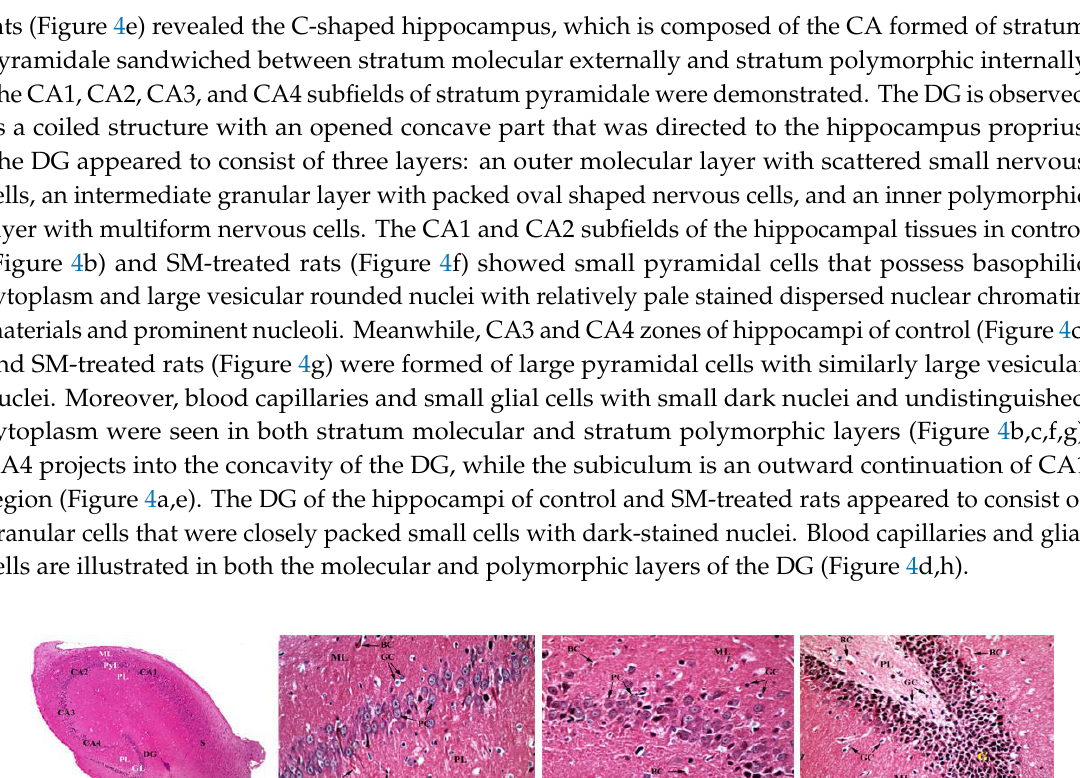
Figure 5. Photomicrographs of the hippocampal tissues of AlCl 3 -treated rats stained with Hx&E showing ( a ) disruption of normal laminar organization, where the hippocampus appeared flattened, formed of CA1, CA2, CA3, and CA4 subfields, DG, and subiculum (S); ( b ) the CA1 subfield had disorganized small pyramidal cells (PC) and some of them appeared shrunken with pyknotic nuclei ( → ). Some glial cells (GC) appeared enlarged in the molecular (ML) and polymorphic (PL) layers; ( c ) another CA1 zone revealed marked shrunken small pyramidal cells (PC) and some of them showed pyknosis ( → ). Dilated congested blood capillaries (BC) and glial cells (GC) were also seen; ( d ) the CA3 subfield revealed large pyramidal cells (PC) exhibiting shrinkage with pyknotic nuclei,